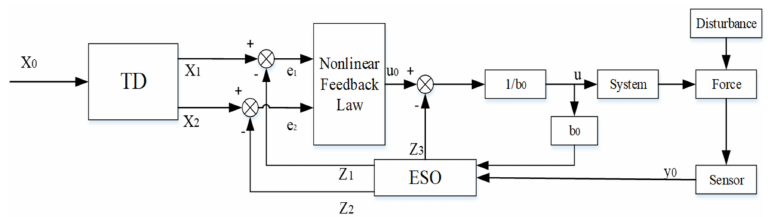
Figure 6. Constant force control system with ADRC topology.